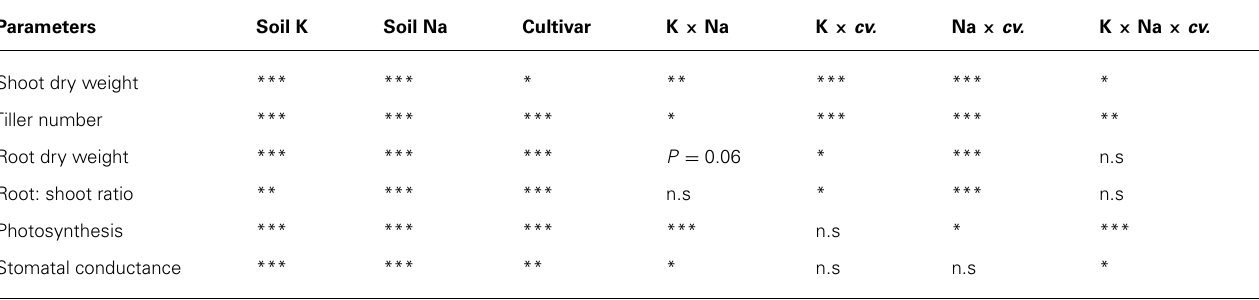
Table 1 | Statistical summary of plant growth and leaf gas exchange in four wheat cultivars (Wyalkatchem, Cranbrook, Gutha, and Gamenya) treated with two K levels (40, 100 mg K/kg) and five Na levels (0, 25, 50, 100, 200 mg Na/kg) for 8 weeks. Parameters